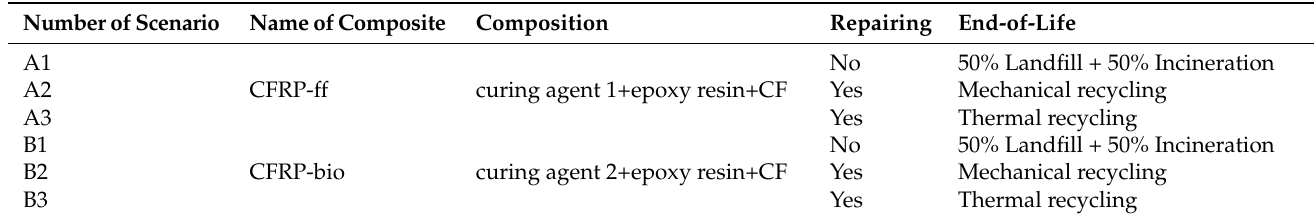
Table 1. Description of the scenarios of the comparative LCA.